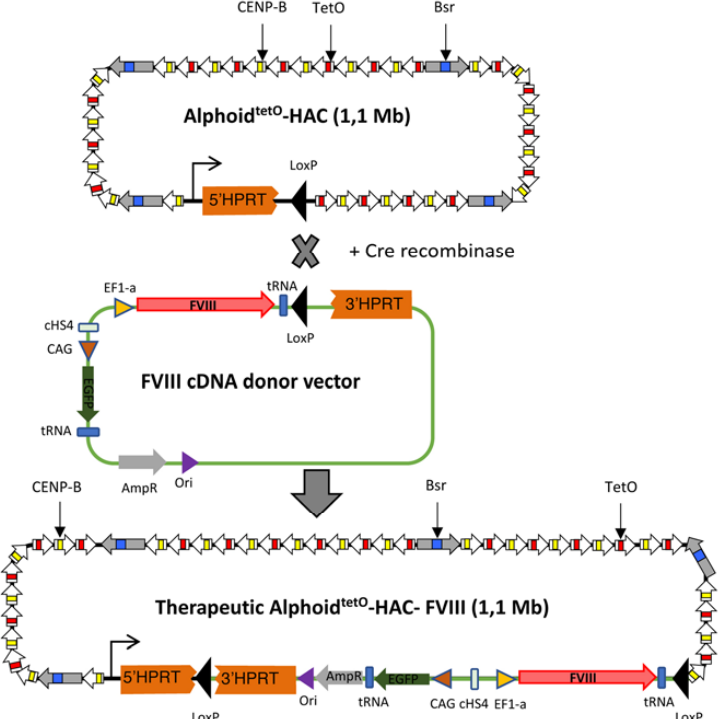
Figure 1. Scheme of construction of the alphoid tetO -HAC-factor VIII vector by Cre-recombinase mediated insertion of the therapeutic human clotting factor VIII DNA. After successful Cre-loxP-mediated recombination of the donor vector with the HAC, the HPRT gene was reconstructed, allowing positive selection on the HAT medium. tetO—a tet operator site replacing the CENP-B box sequence. Bsr—the blasticidin resistance gene. White arrows with yellow stripe—alphoid monomers with the CENP-B box sequence. White arrows with a red stripe—alphoid monomers with tetO replacing the CENP-B box sequence. 5 (cid:48) HPRT—5 (cid:48) and 3 (cid:48) HPRT—3 (cid:48) , according parts of the HPRT gene. The loxP sites are indicated by black arrowheads. The tRNA insulator indicated by a blue rectangle. cHS4-the insulator indicated by a light green rectangle. The FVIII cDNA -indicated by a red arrow. The EF1-alpha promotor (EF1- α )—indicated by a yellow arrowhead. CAG promoter-indicated by a brown arrowhead. The EGFP gene—indicated by a green arrow). The ampicillin resistance element (Amp R )-indicated by a grey arrow. The origin of replication (Ori)-indicated by a purple arrowhead. 3.2. Recombinase ‐ Mediated Insertion of the Targeting Vector into Alphoid tetO ‐ HAC